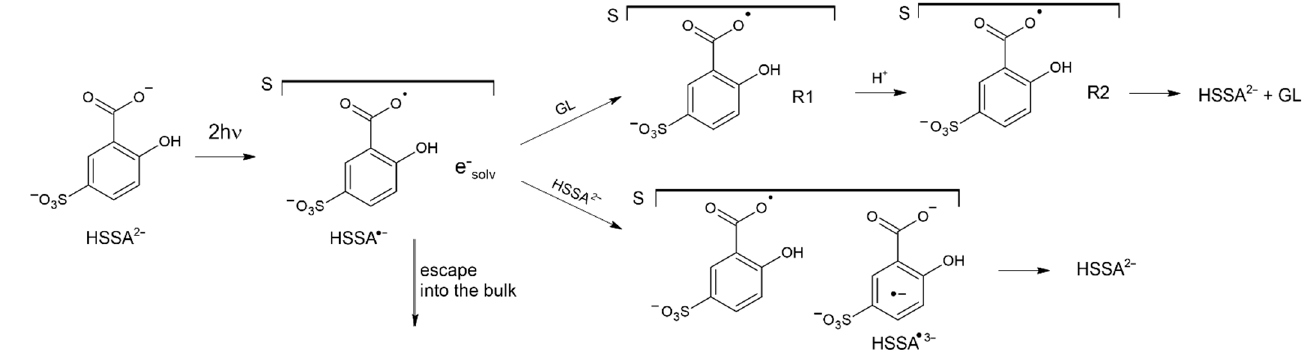
10 of 14 Figure 5. 1 H NMR and TR ‐ CIDNP (blue) spectra of 1 mM HSSA 2 − in water (pH = 10) and 1 mM HSSA 2 − and 1.5 mM GL in water (pH = 10). The delay time between the laser pulse and NMR detec ‐ tion pulse is 50 μ s for both